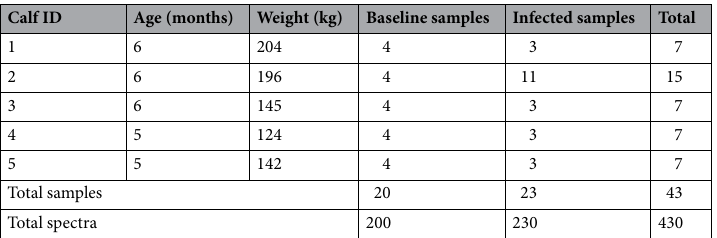
Table 1. Number of blood samples contributing to the databases collected before and after the M. haemolytica challenge. Calf 2 presented mild signs of the infection from Day 1 until Day 19 when his signs aggravated, and antibiotics were then